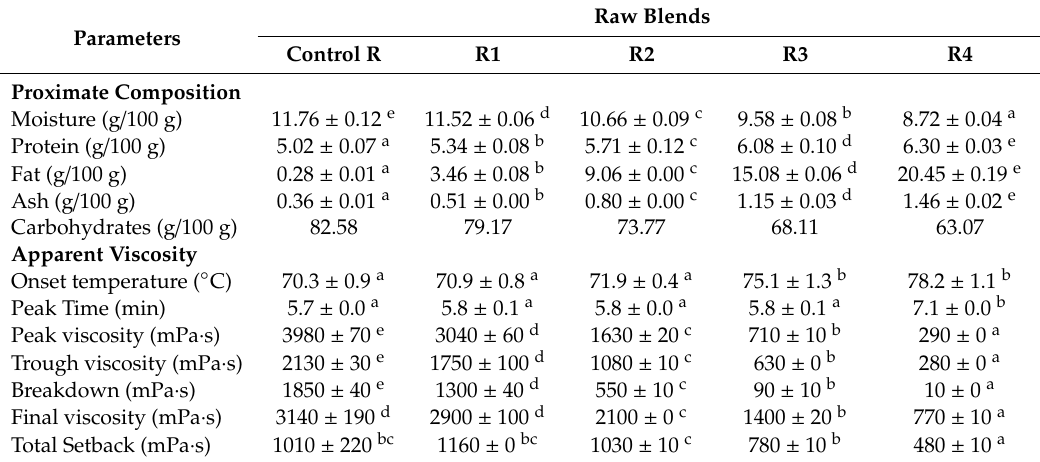
Table 1. Proximate composition and apparent viscosity of raw blends containing increasing concentrations of tiger nut flour (R1: 10%; R2: 30%; R3: 50%; R4: 70%).